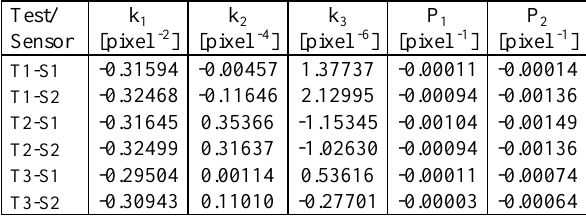
Table 4. Tangential distortions coefficients in function of tests and sensors considered